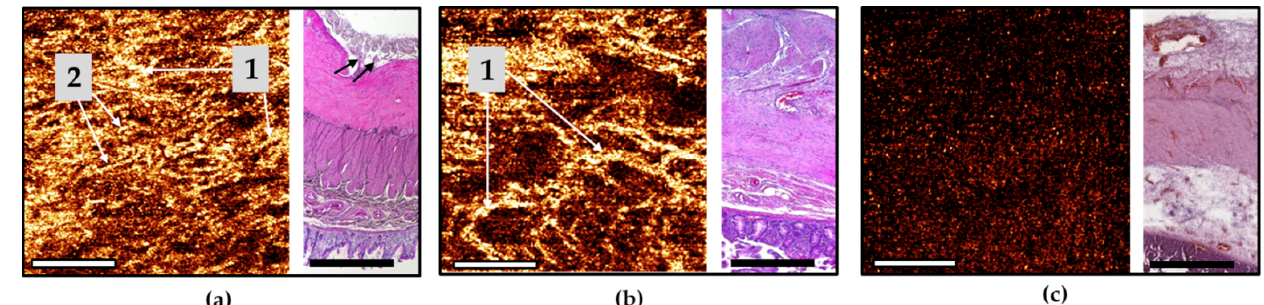
Figure 6. En-face OCTA images of the human small intestine in norm and ischemia with the corresponding histology. ( a ) A network of blood vessels of different diameters in the normal intestine wall; ( b ) ischemic bowel without extensive necrosis—noticeable rarefaction of the vasculature and in some areas the background formed by microvessels disappeared; ( c ) ischemic bowel with transmural necrosis. OCTA images in ( a , b ) demonstrate the microvascular network from the tissue surface down to a depth of 500 µm, which corresponds to the blood vessels of the serosal and longitudinal muscular layers, in ( c ) the blood vessels are not visible, only the signal noise (snow-like spots) is present. Black arrows in histological image ( a ) indicate non-damaged sub serous blood vessels. 1—intramural blood vessels, 2—light background from the microvessels. Histological specimens are stained with H&E. Scale bars 1 mm.